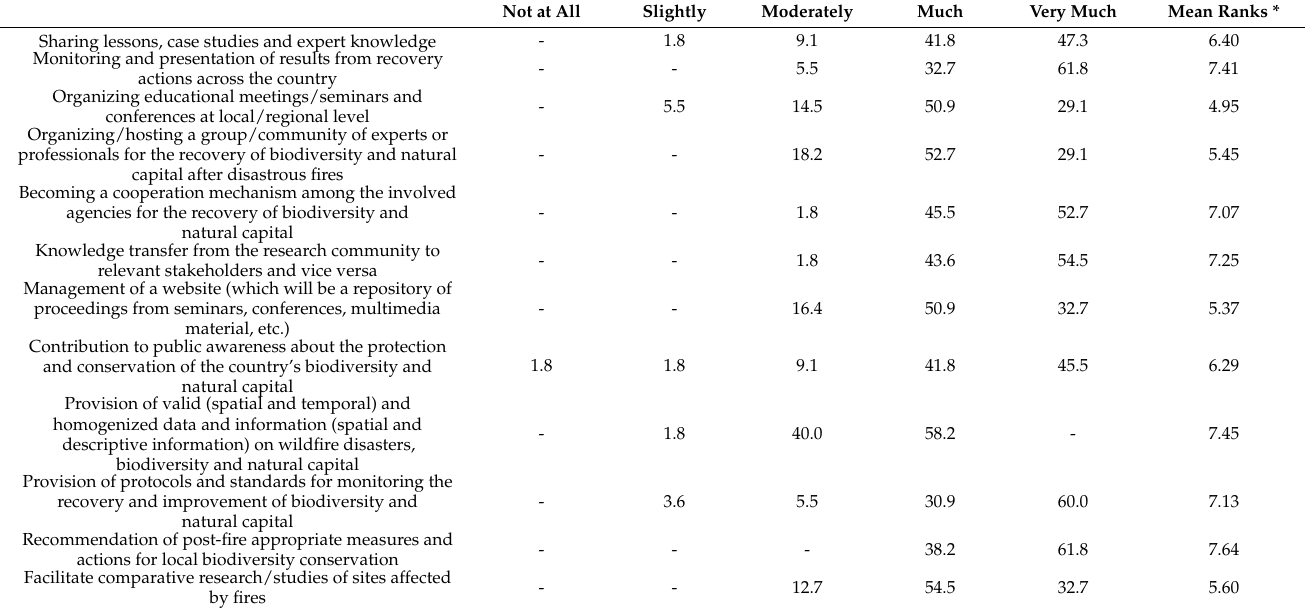
Table 6. Percentage units and differences among respondents’ views on Hub’s functions. Not at All Slightly Moderately Much Very Much Mean Ranks